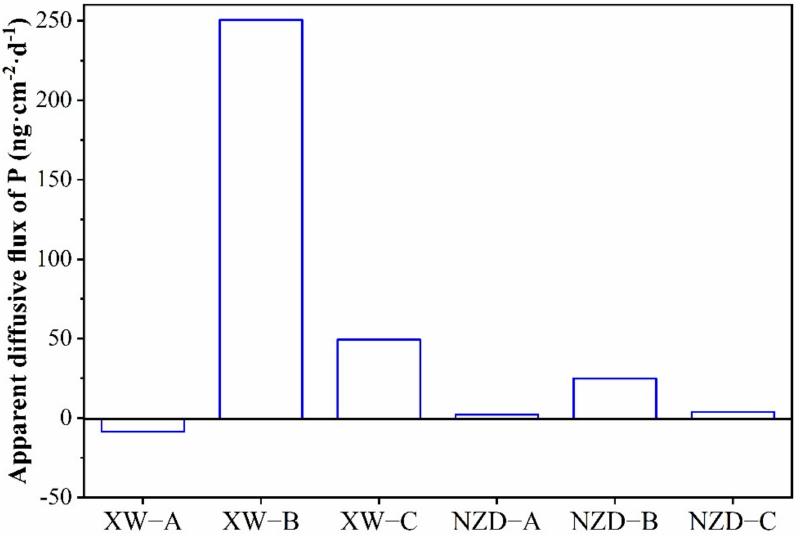
Figure 7. Apparent diffusive flux of P across the sediment–water